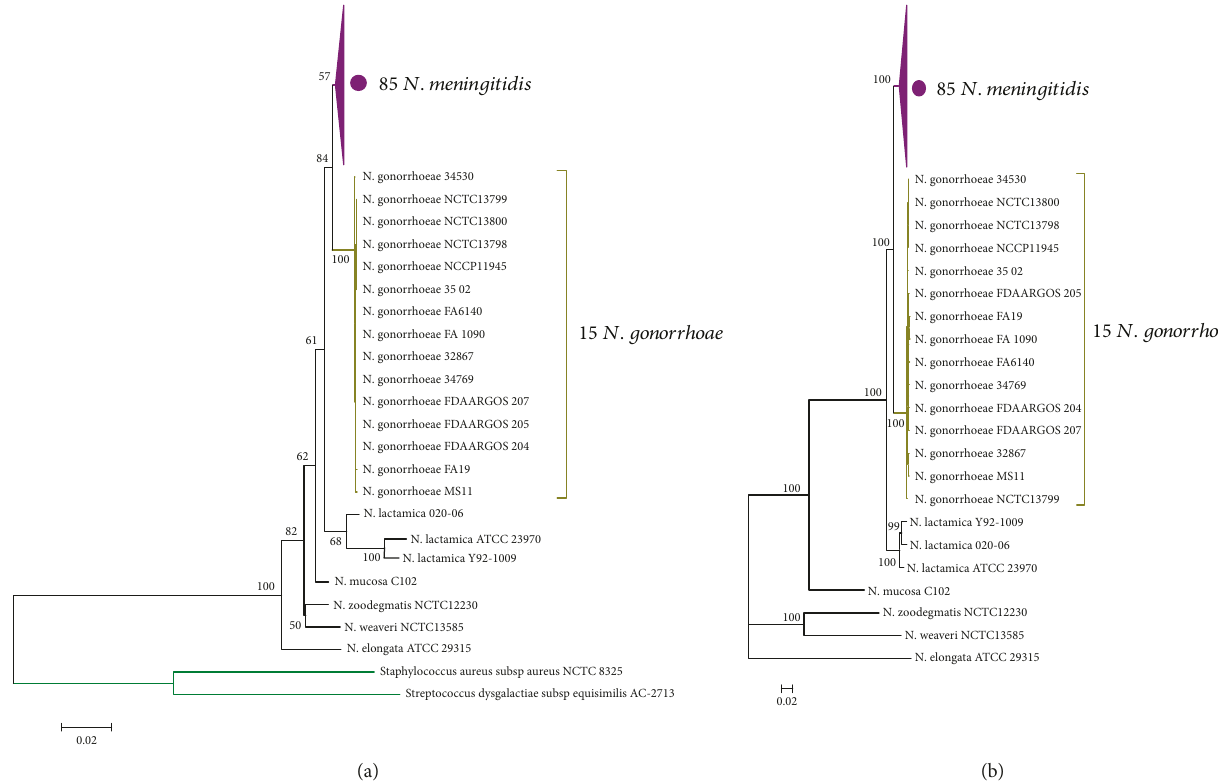
Figure 2: Phylogenetic analysis of Neisseria strains included in this study. (a) Phylogenetic tree of 107 Neisseria strains constructed by neighbour joining (NJ) approach using 16s rRNA genes with the Kimura 2-parameter substitution model, bootstrapped × 1000 replicates. Staphylococcus aureus subsp. aureus NCTC 8325 and Streptococcus dysgalactiae subsp. equisimilis AC-2713 were used as outgroups. Approval values of each major node were indicated. The subtree of N. meningitidis was compressed and denoted in purple. (b) Phylogenetic tree constructed by a maximum likelihood (ML) approach using concatenated single-copy gene dataset, bootstrapped × 100 replicates. Approval values of each major node were indicated. The subtree of N. meningitidis was compressed and denoted in